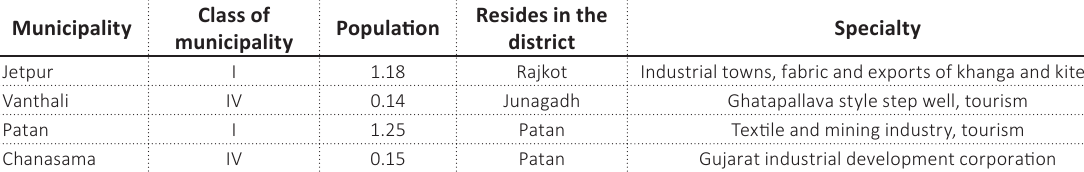
Table 2. Selected municipalities and their